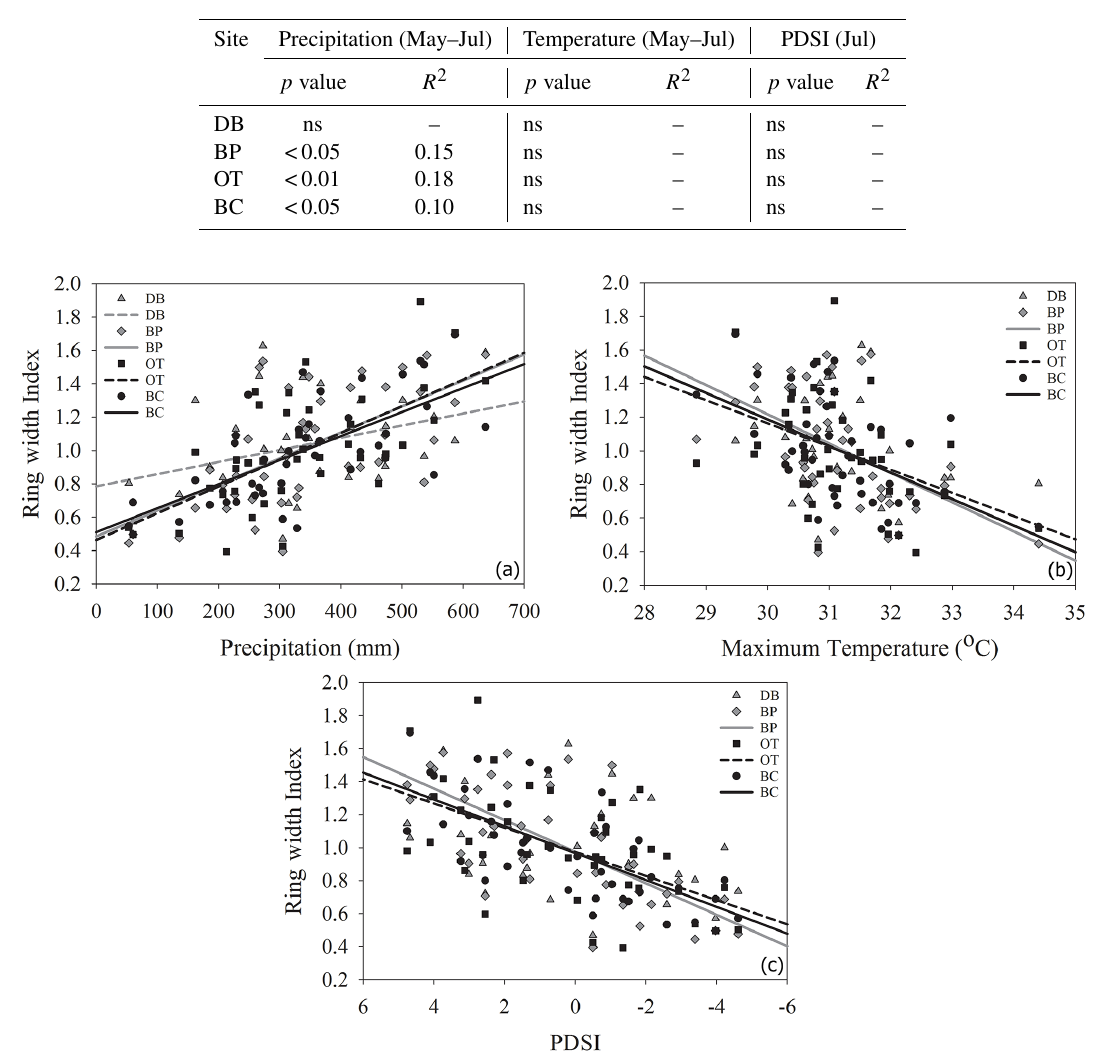
Figure 5. Relationship between ARSTAN ring width index and midgrowing season precipitation (a) , temperature (b) and PDSI (c) . Site DB is represented by gray triangles, BP by gray diamonds, OT by black squares and BC by black circles. Regression lines are shown only for statistically significant relationships.